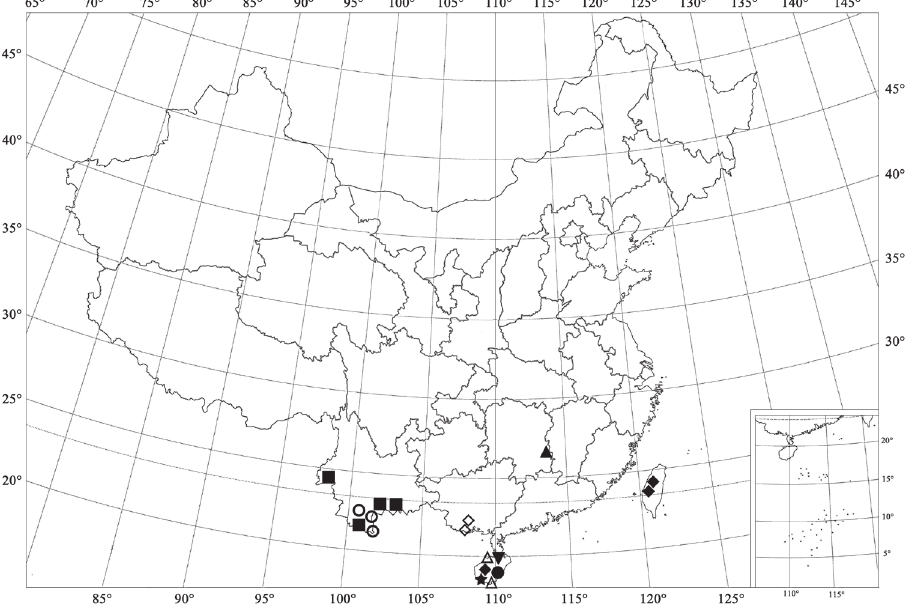
Figure 93. Distribution map. ○ M. erythrinum Wang & Ren, sp. n. ● M. fuscum Wang & Ren, sp. n. △ M. glossoides Wang & Ren, sp. n. ▲ M. shennongensis Wang & Ren, sp. n. ▼ M. semilunatum Wang &